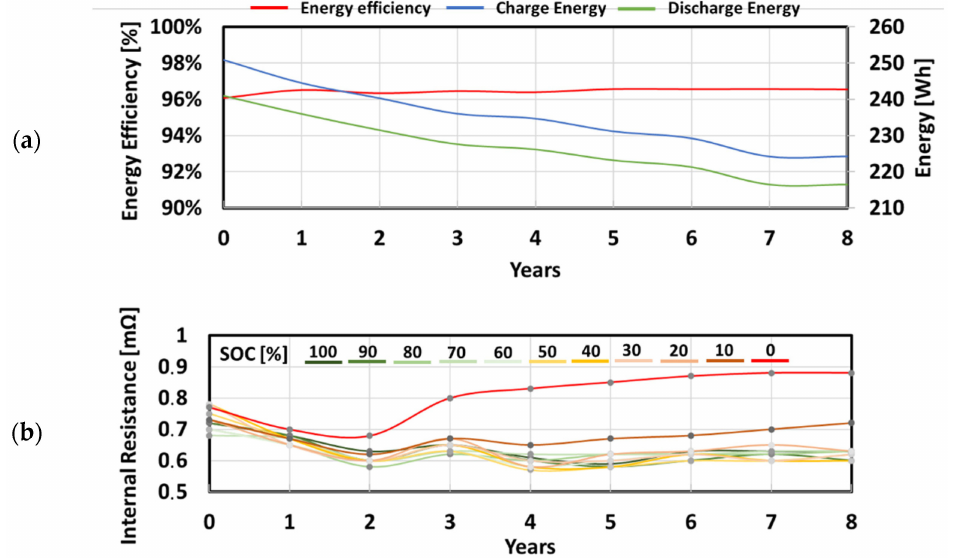
Figure 10. ( a ) Evolution of Charge and Discharge Energy and Energy efficiency with ageing. ( b ) Evo- lution of Internal cell resistance for different SOC values with